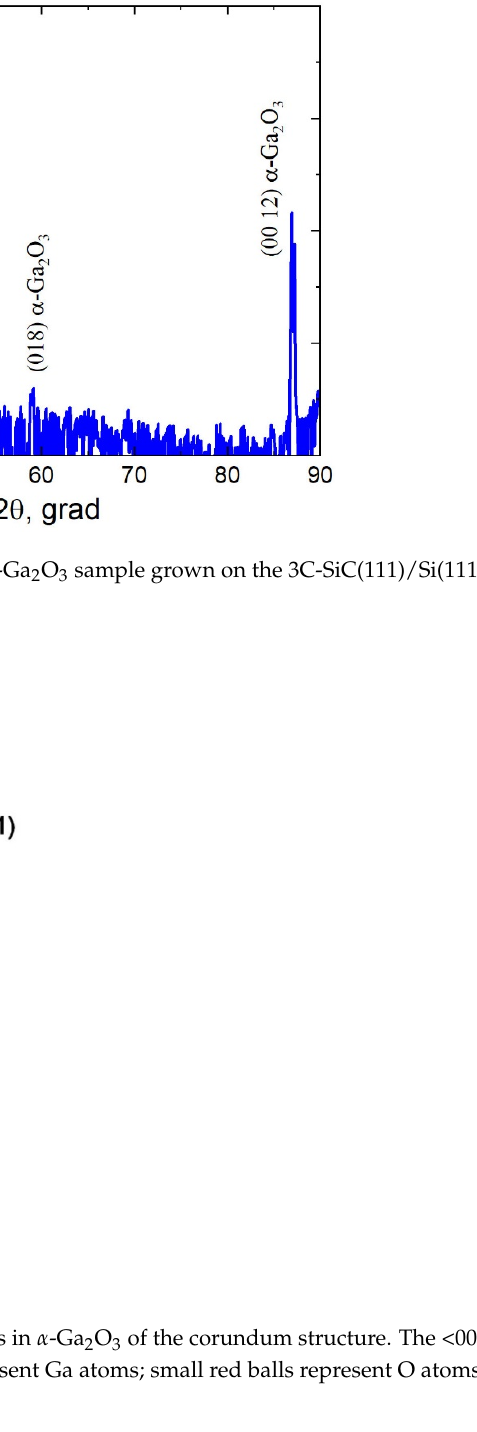
Figure 14. Configuration of atoms in 𝛼 -Ga 2 O 3 of the corundum structure. The <001> axis is directed upwards. Large green balls represent Ga atoms; small red balls represent O atoms.